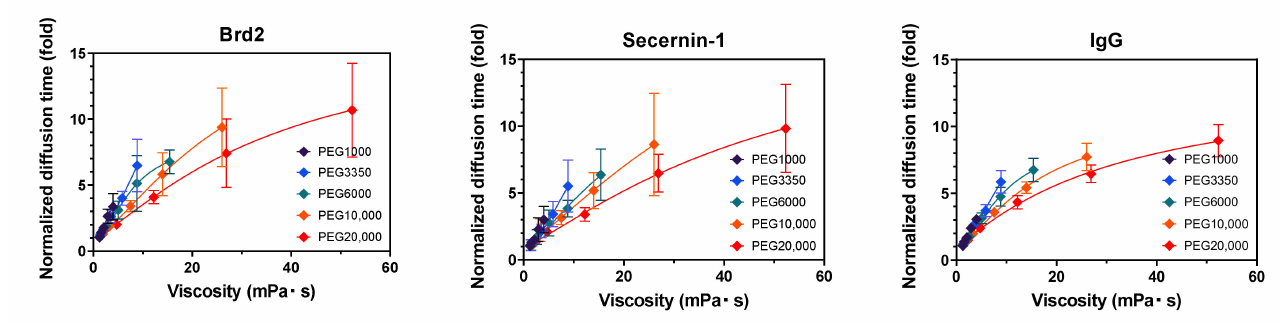
Figure 2. Normalized τ D values of Brd2, secernin-1, and IgG in di ff erent PEG solvents. The measurements ( n = 5) were performed in duplicate. The measured τ D values were analyzed by the two-component analysis software of the instrument (MF20) and decomposed into two τ D values owing to the protein and contaminating free-labeling reagent, then calculated τ D values of proteins were normalized as in Figure